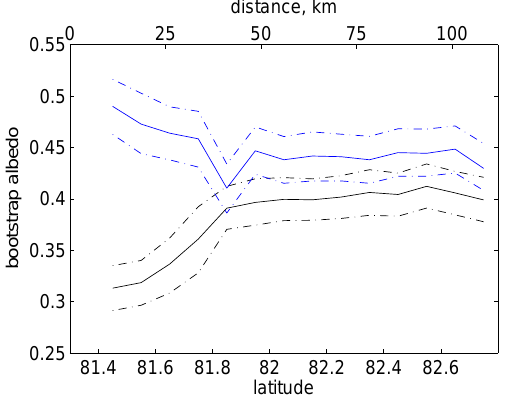
Figure 10. Latitudinal distribution in areal (black) and sea-ice (blue) bootstrap albedo derived from the six flight tracks. Dash- dotted lines show the respective 95% confidence intervals on the